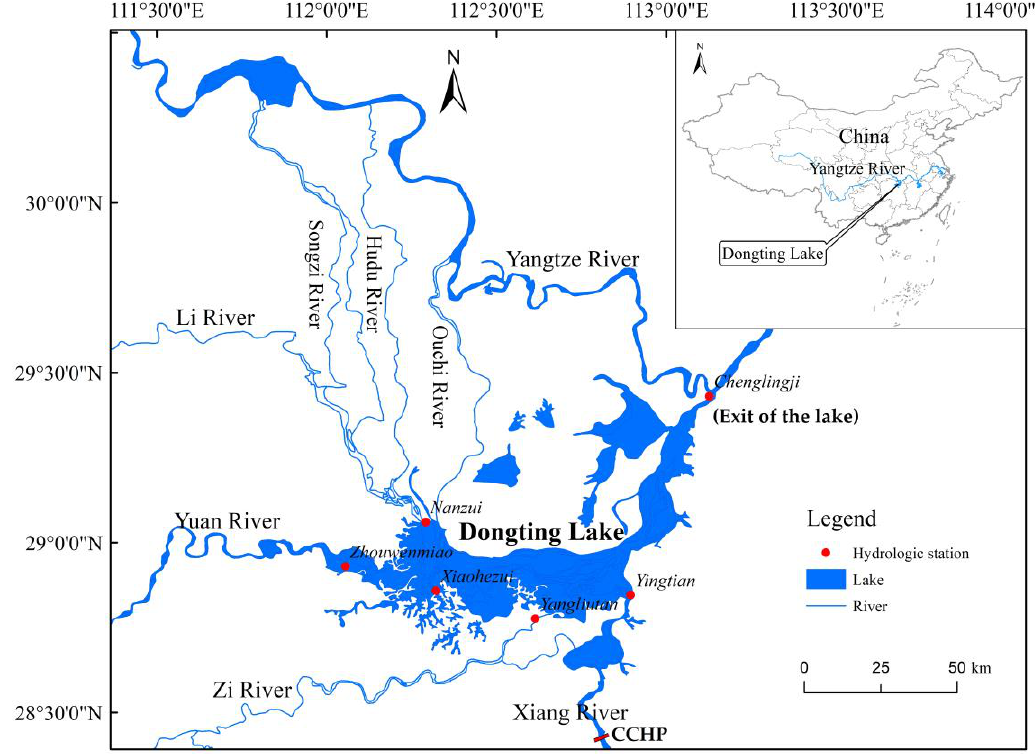
Figure 1. Location of Dongting Lake and the distribution of hydrological stations.